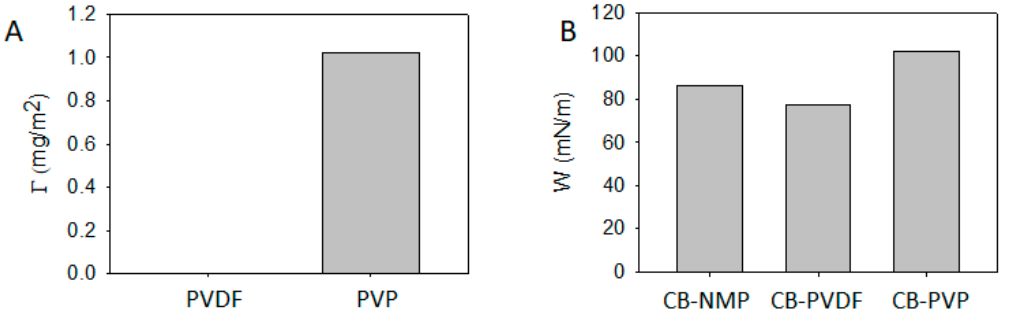
Figure 4. ( A ) Adsorption amount of PVDF and PVP on CB surface, respectively in NMP solvent. ( B ) Work of adhesion for CB-NMP, CB-PVDF and CB-PVP which suggests that PVP is preferably adsorbed on CB surface, whereas PVDF is not.